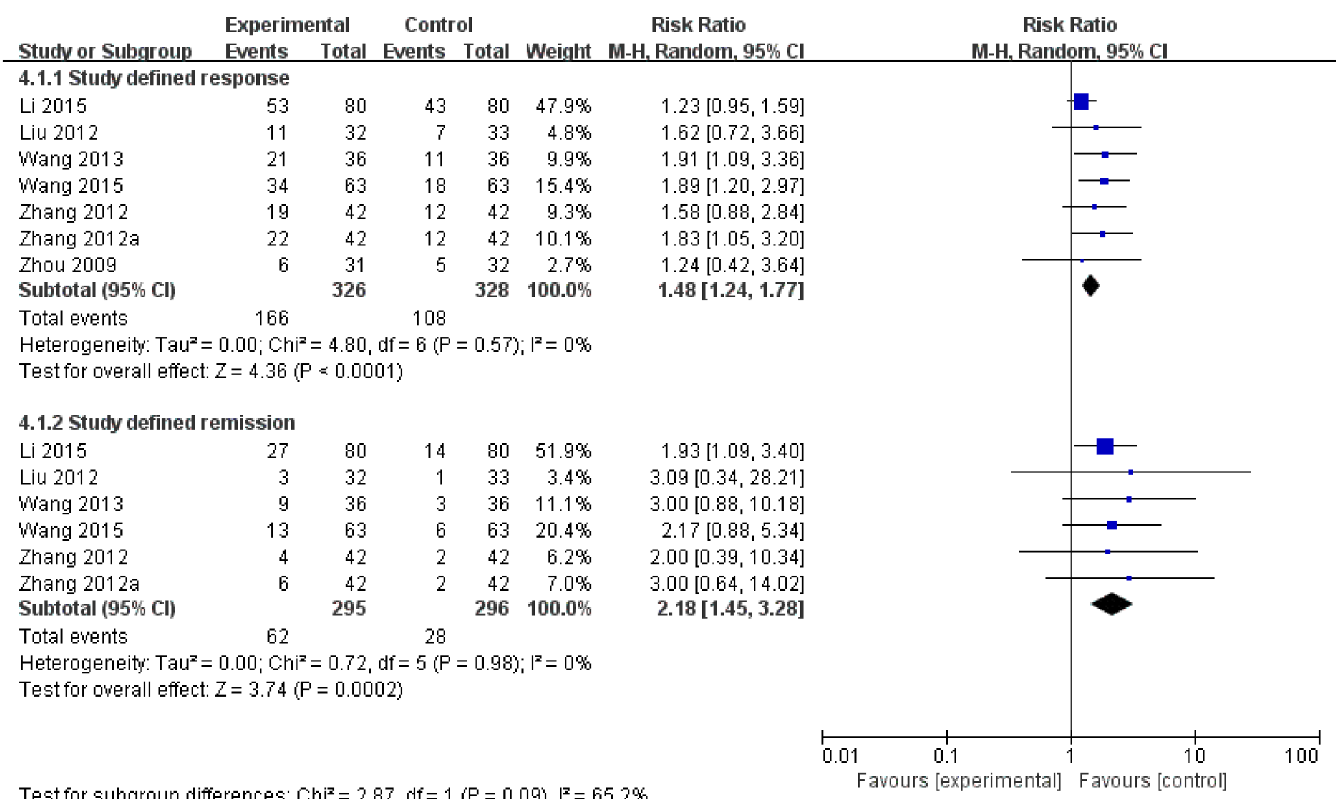
Fig 4. ECT added to non-clozapine antipsychotic medications for treatment resistant schizophrenia: study-defined response and remission.